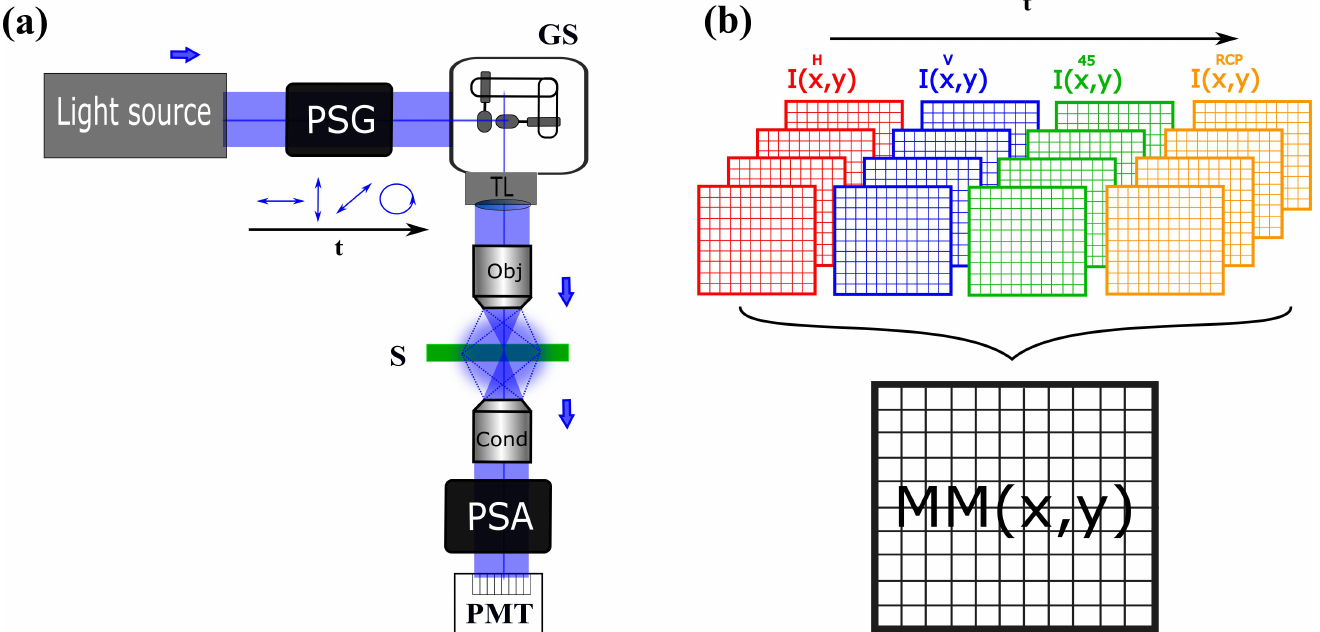
Figure 2. ( a ) Block diagram of a typical MM SLM configuration based on the sequential encoding/decoding of the polarization states from Reference [45]. ( b ) Schematic presenting the extraction of the MM images from the measured intensities images in the sequential approach. PSG: polarization states generator. PSA: polarization states analyzer. Obj: microscope objective. Cond: Condenser. GS: galvanometric scanner. TL: tube lens. S: sample. PMT: Photomultiplier tube. t: temporal polarization states generation. I H , I V , I 45 , I RCP : intensities collected at the generated horizontal, vertical, 45 ◦ and Right Circular Polarization (RCP) polarized